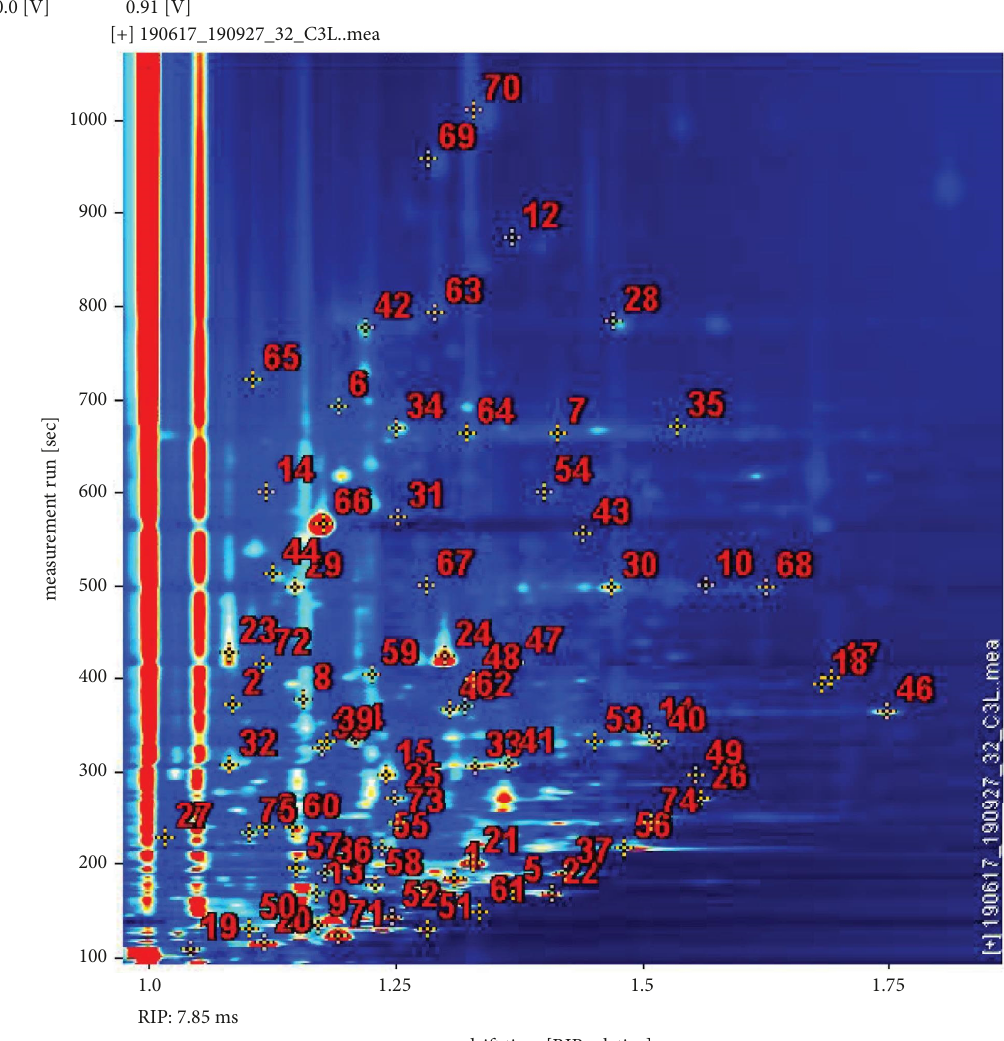
Figure 2: 75 marked peaks were qualitatively identifed in the ion mobility spectrum of sample